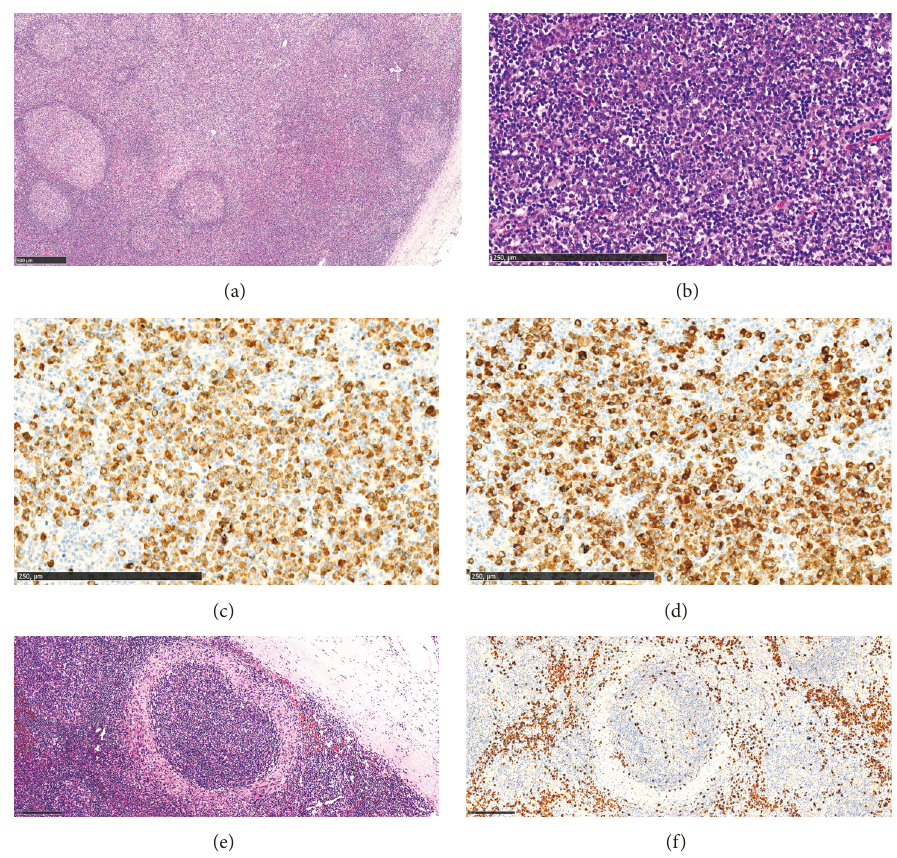
Figure 3: Histological findings in a patient with IgG4-related lymphadenopathy. (a) Low magnification showing expansion of the interfollicular zone (H&E). (b) At higher magnification, numerous plasma cells are identified in the interfollicular zones (H&E). (c, d) Strong infiltration of IgG4-positive cells, hot spot (c) (IgG4 immunostaining) and IgG-positive cells, hot spot (d) (IgG immunostaining). The IgG4 / IgG ratio is 92%. (e) A granulomatousfocus, arranged in a ring-like fashion around a lymphoid follicle, is shown, a feature called perifollicular granuloma (H&E). (f) Another perifollicular granuloma, accompanied by numerous IgG4-positive cells (IgG4